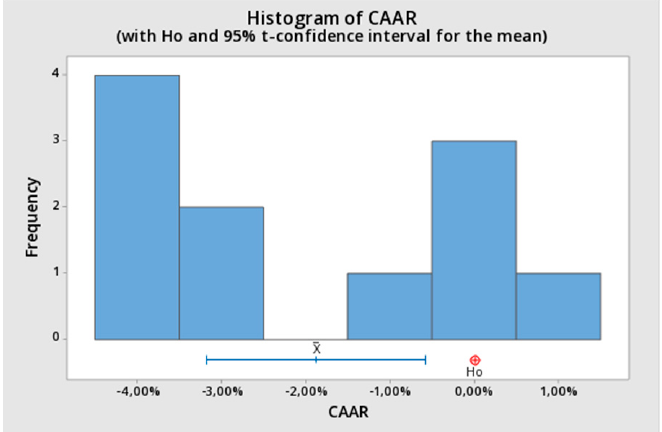
Figure 6. t -Test histogram of CAAR for E ( − 5,+5) .